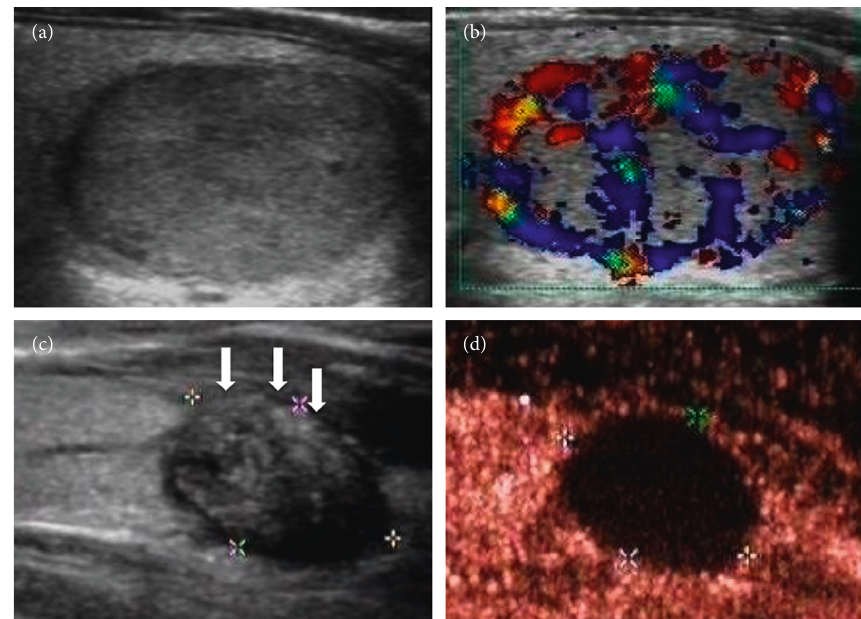
Figure 8: (a, b) A 23-year-old female had an oval solid nodule in the thyroid. The nodule had clear margin and abundant peripheral and internal blood flow signals. The nodule was classified as TI-RADS 3 and considered to be a follicular adenoma. (c) The patient received ultrasound-guided microwave ablation. 1 year after treatment, the nodule became smaller. The anterior capsule of the thyroid was interrupted because of thermal ablation. (d) CEUS showed no enhancement in the nodule suggesting complete